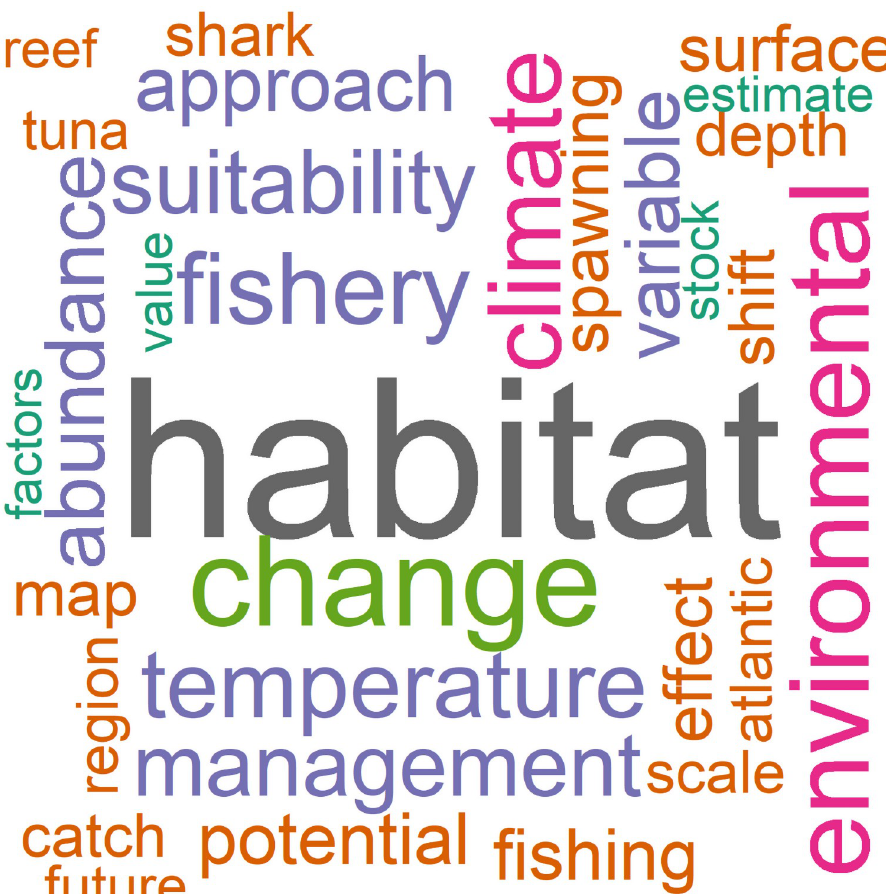
Fig 2. Word cloud representing research themes of marine fish predictive modeling studies. Word size is proportional to its frequency in article abstracts derived from a search of articles from 2007–2018 ( n = 225).